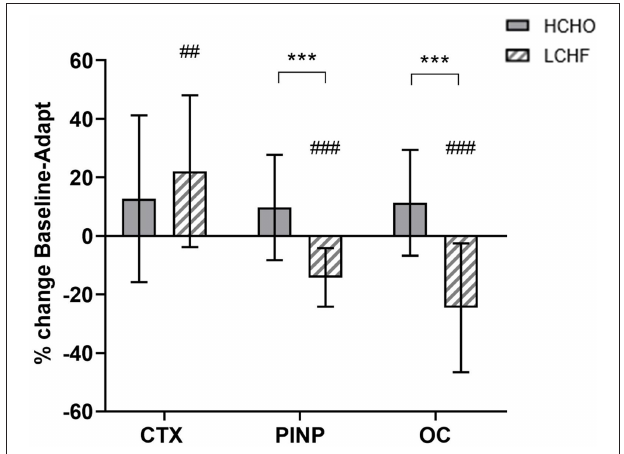
FIGURE 2 | Percentage change in fasting serum C-terminal telopeptide of type I collagen (CTX), procollagen 1 N-terminal propeptide (P1NP) and osteocalcin (OC) for high carbohydrate (HCHO; solid bars) and low CHO high fat (LCHF; striped bars) after the 3.5-week dietary intervention. Data are means ± standard deviations. *** p < 0.001 Significant between-group difference; ## p < 0.01; ### p < 0.001 Significant change from Baseline within-group.